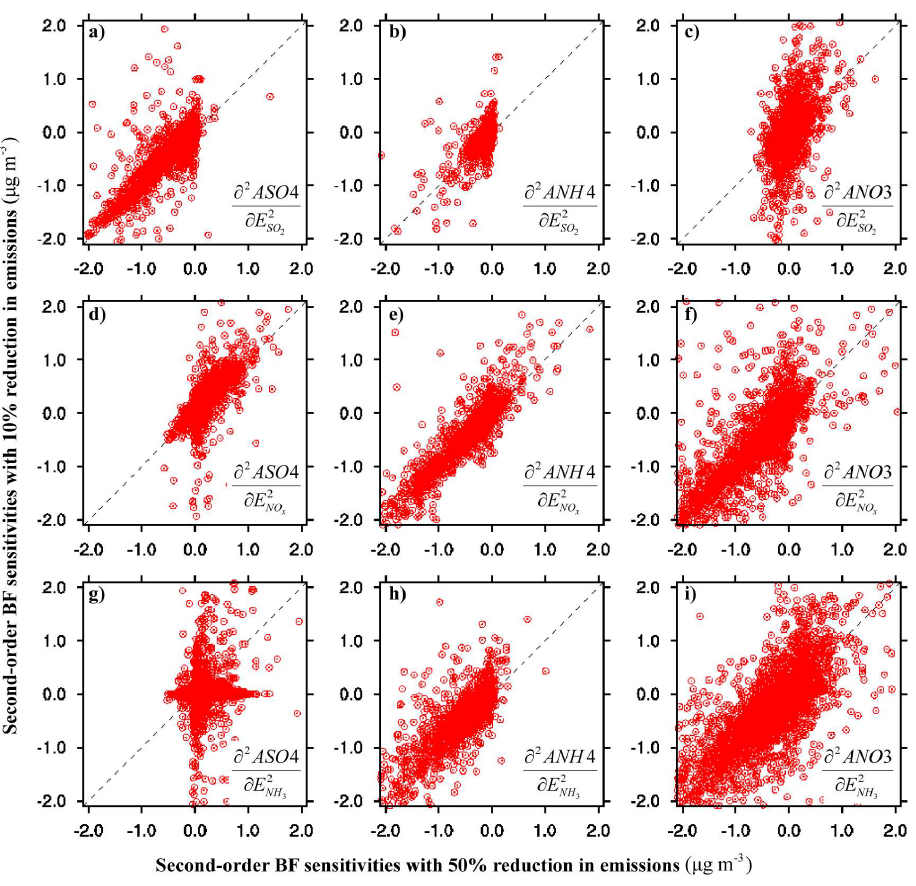
Fig. 7. Comparison of second-order BF sensitivities calculated with 10% and 50% perturbation in emissions using CMAQ simulation on 2 January 2004 at surface layer. ASO4, ANH4, and ANO3 denote aerosol sulfate, aerosol ammonium, and aerosol nitrate, respectively.